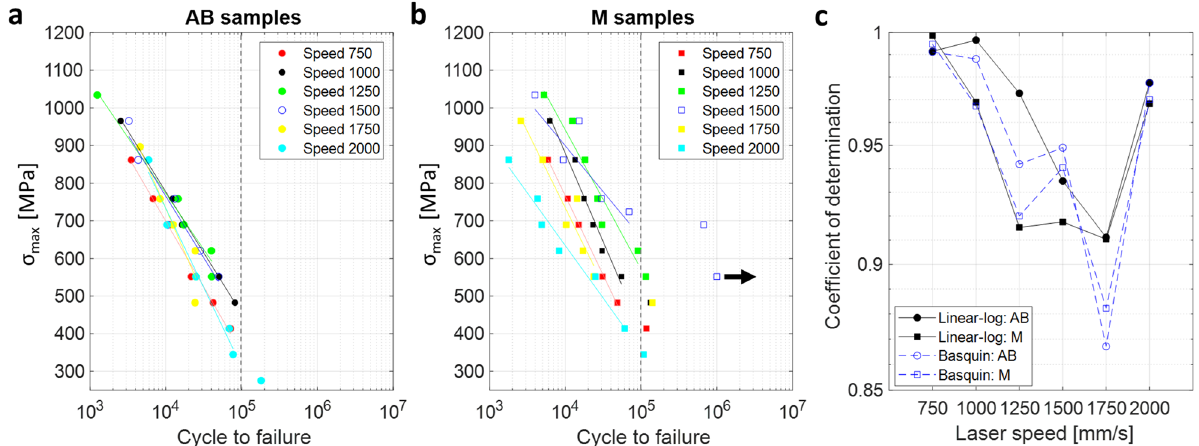
Figure 11. (a) The plot of stress-fatigue life (S–N) for AB samples. The fitting results from the linear-log model included the HCF regime of data (N < 10 5 ). (b) The S–N plot for the machined (M) samples. The fitting results from the linear-log model also included the HCF regime of data (N < 10 5 ). The arrow marker represents the runout. (c) Comparison of the linear-log and Basquin models based on the R 2 of each fitting function. The fitting lines in the log–log coordination were also presented in the Supplementary Information (Fig. S4, Table S1).